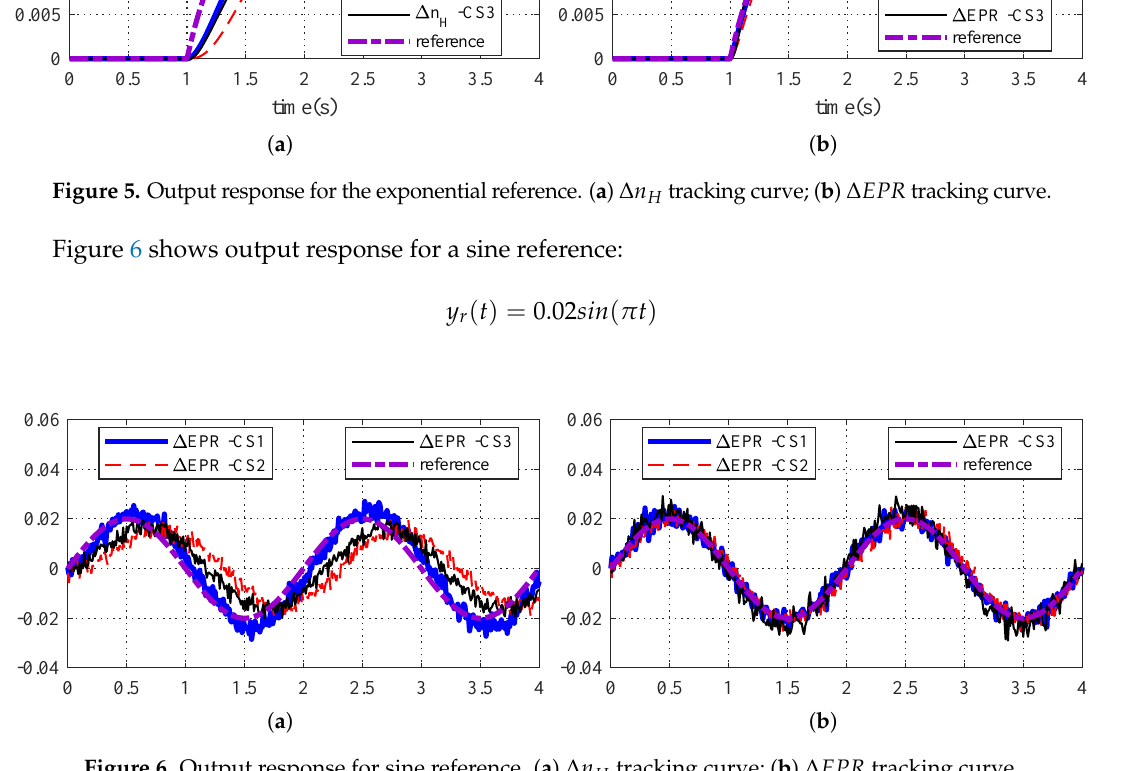
Figure 6. Output response for sine reference. ( a ) ∆ n H tracking curve; ( b ) ∆ EPR tracking curve. A Gaussian white noise D wp w p ∼ N ( 0, 0.002 ) is added to the output. From Figure 6a,b, we can see that the output curve of CS1 has better tracking performance than those of CS2 and CS3. The variation of the elements in the matrix K 3 ( t ) over time is shown in Figure